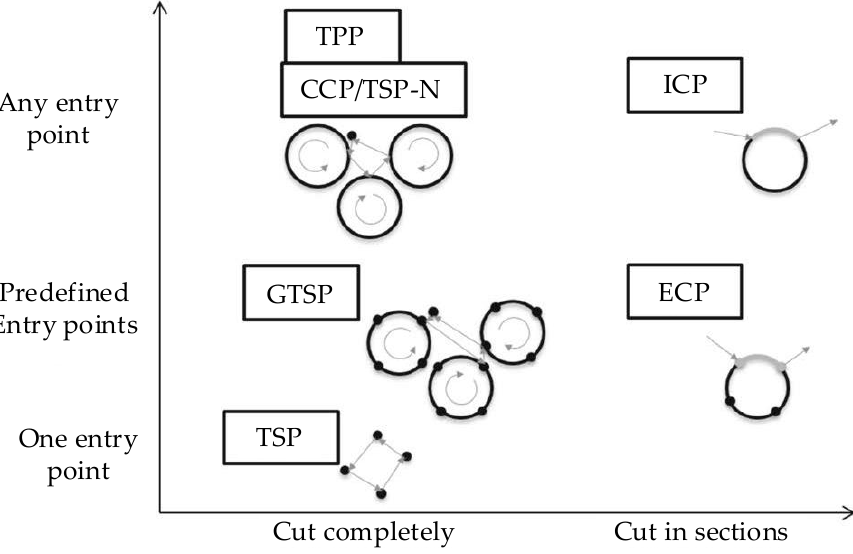
Figure 3. Classification of laser cutting path planning problems.